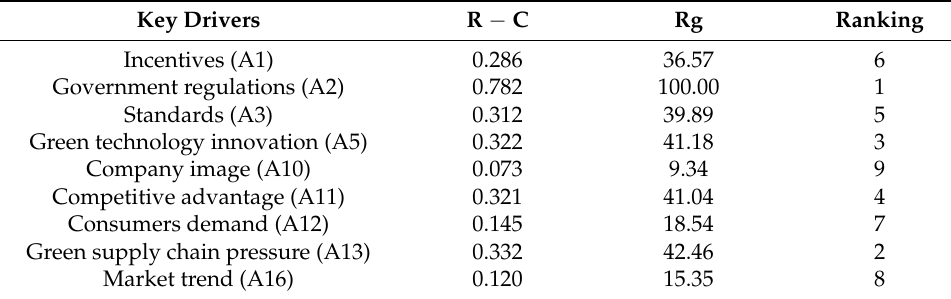
Table 8. The sequencing of the key